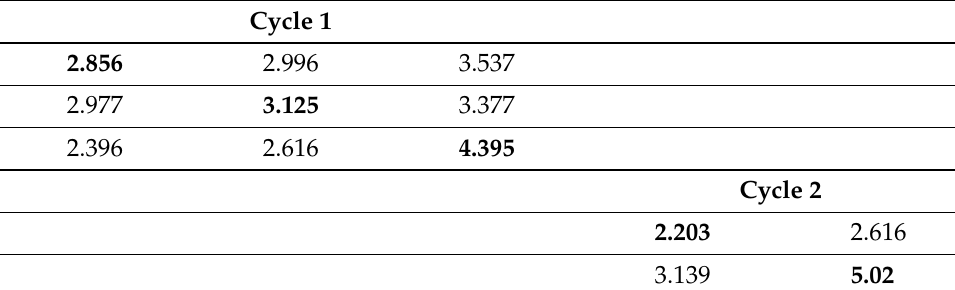
Table 10. RSS scheme from the GB( θ , λ ) distribution when c = 2 and n = 5.